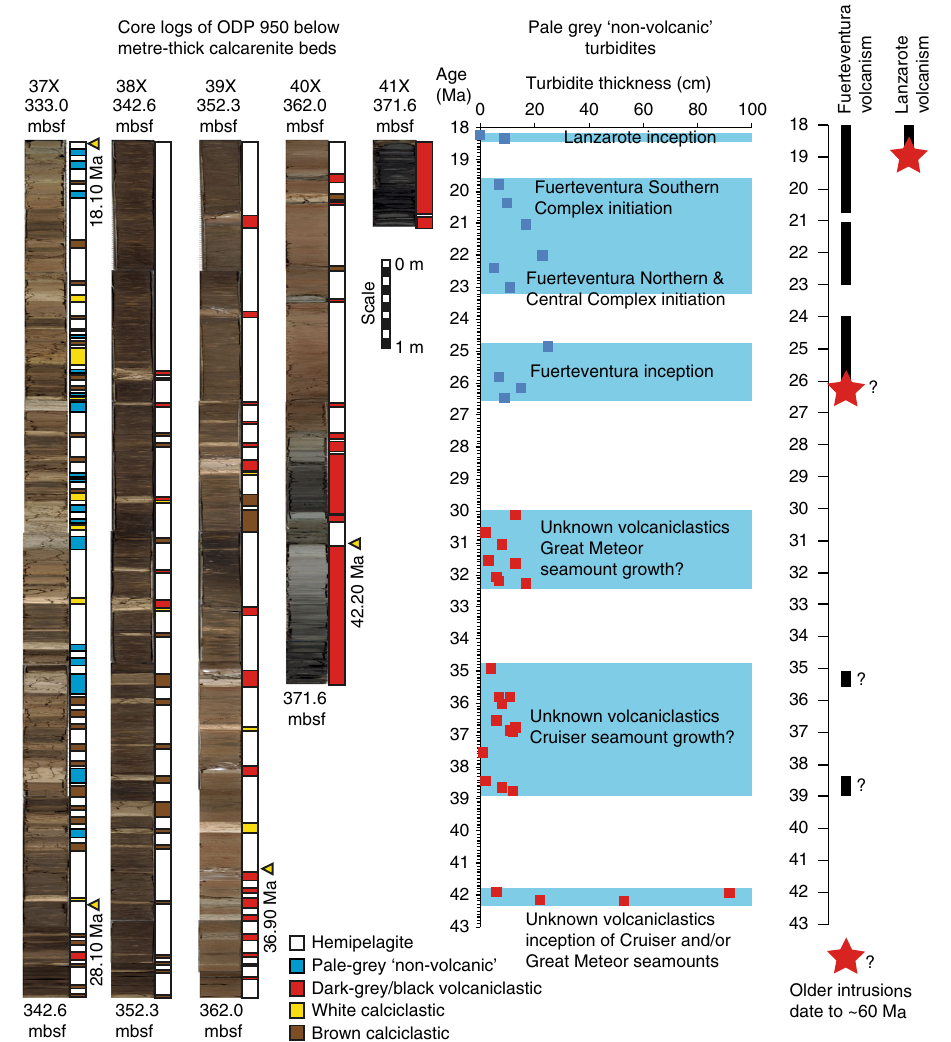
Fig. 4 Core log of stratigraphy at ODP 950 below 330 mbsf. Temporal distribution of pale-grey ‘ non-volcanic ’ turbidites represented by blue lithology in legend signifying inception and emergence of the eastern Canary Islands represented by blue squares. Black layers within the oldest volcaniclastic turbidites are sand-rich with abundant basalt clasts. These black volcaniclastic turbidites represent failure of growing volcanic structures adjacent to the Madeira Abyssal Plain, and likely represent landslides from the Cruiser or Great Meteor seamounts (red squares). The ages of inception from age estimates of the Basal Complexes 29 are show as red stars, the dates of inception of Fueteventura are compounded by dates from metamorphosed